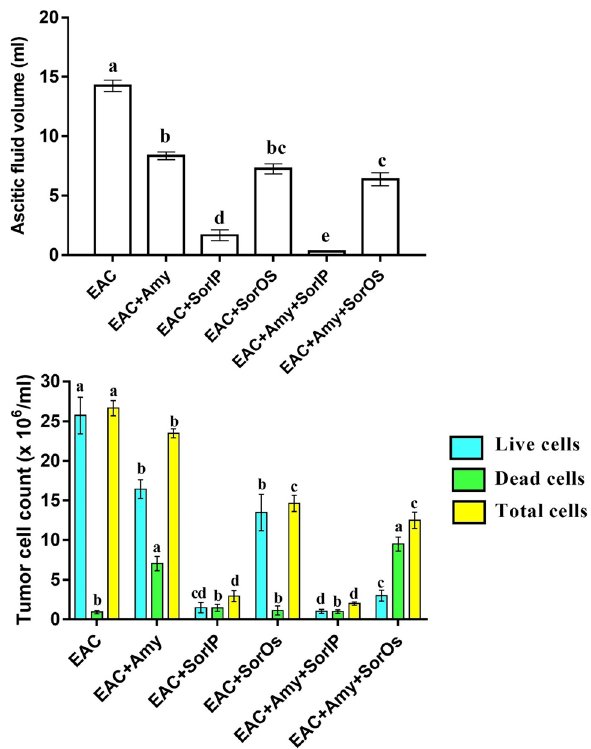
Figure 1. Tumor ascitic fluid volume and count of live and/or dead EAC cells in EAC-bearing mice after treatment with amygdalin and/or sorafenib. Data were presented as means ± SEM (n = 7). Small (a–e) letters showed the marked change at P ≤ 0.05. The significant were expressed by dissimilar letters above columns with the same color.